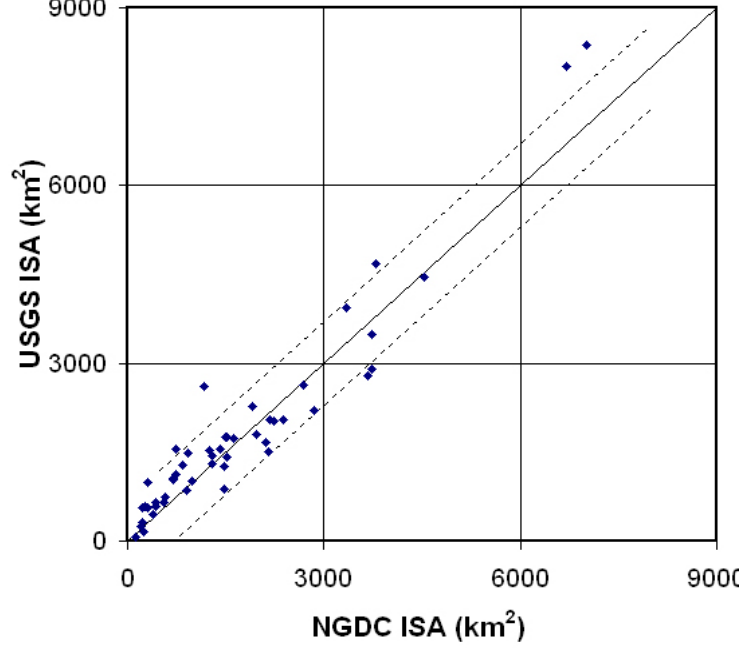
Figure 7. Scattergram of the aggregated ISA for the forty-eight states of the conterminous USA. The solid diagonal line marks the position where the estimates are equal. The dashed lines mark the two standard deviation (702 km 2 ) positions for NGDC estimation